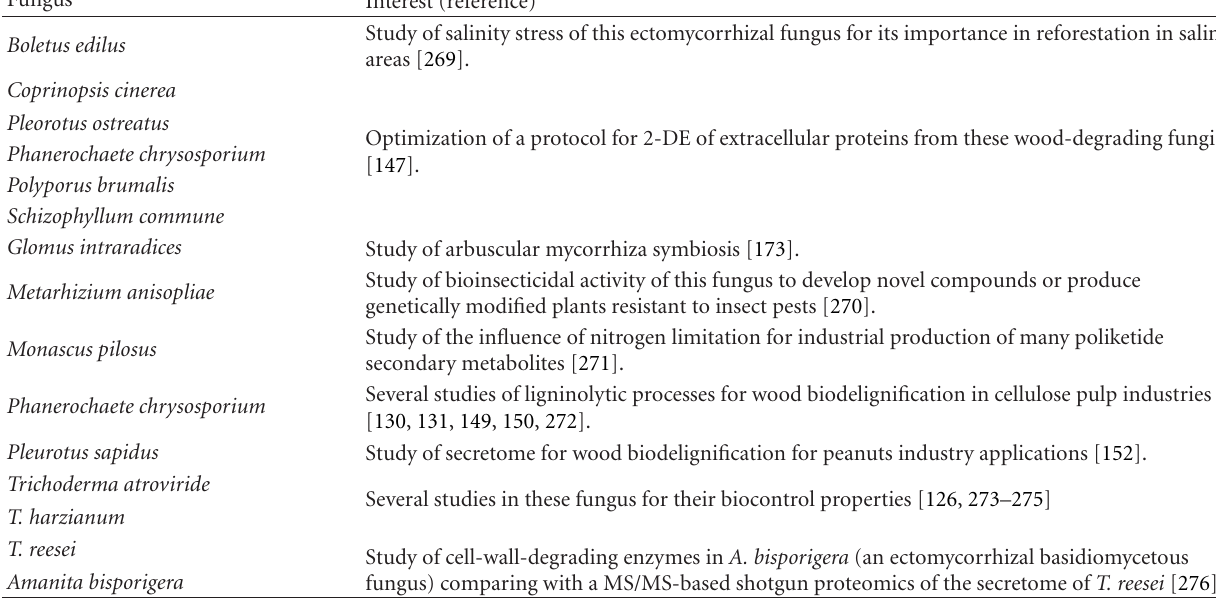
Table 7: Original proteomics papers published on fungi for biotechnological or agricultural